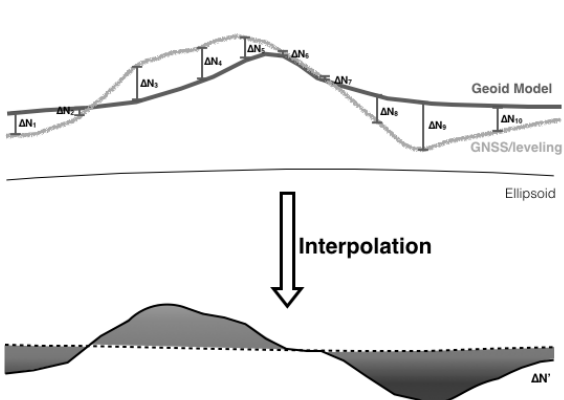
Figure 3 - Corrector surface generation (see the colors in the online